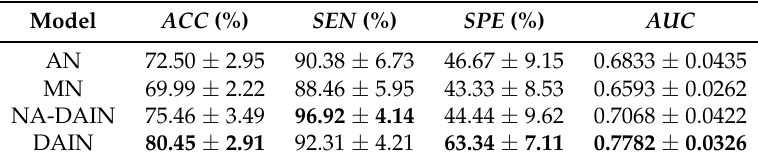
Table 7. Classification performance of different 2D models for T2 task.